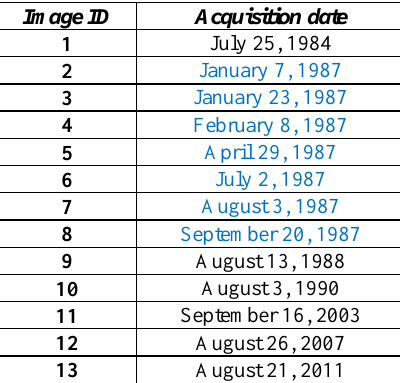
Table 1. Landsat/TM images for the simultaneous